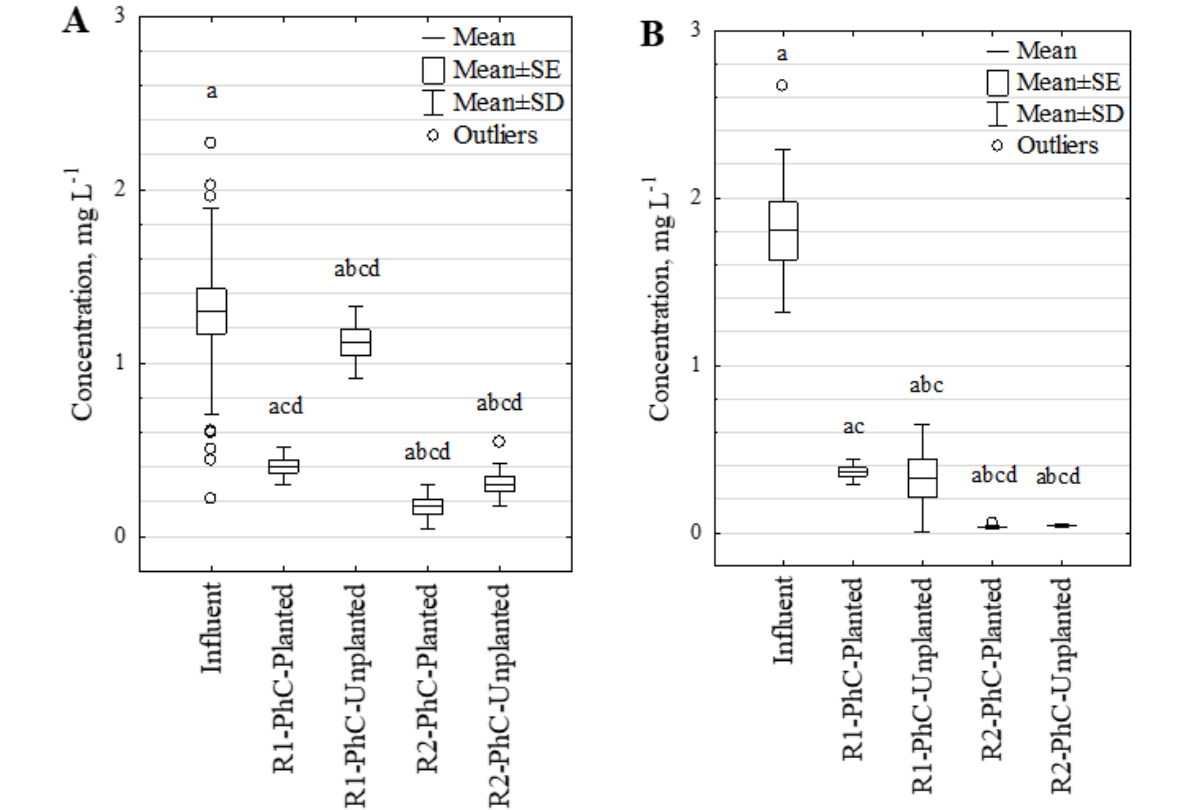
Figure A3. DCF ( A ) and SMX ( B ) concentration (mg L −1 ) in wastewater from CWs. (a) Statistically significant differences between the wastewater influent and effluent (Mann-Whitney U test, p < 0.05); (b) Statistically significant differences between DCF and SMX concentration (Mann-Whitney U test, p < 0.05); (c) Statistically significant differences between counterpart types of columns (CTRL or PhC) with different frequency of wastewater dosing (Mann-Whitney U test, p < 0.05); (d) Statistically